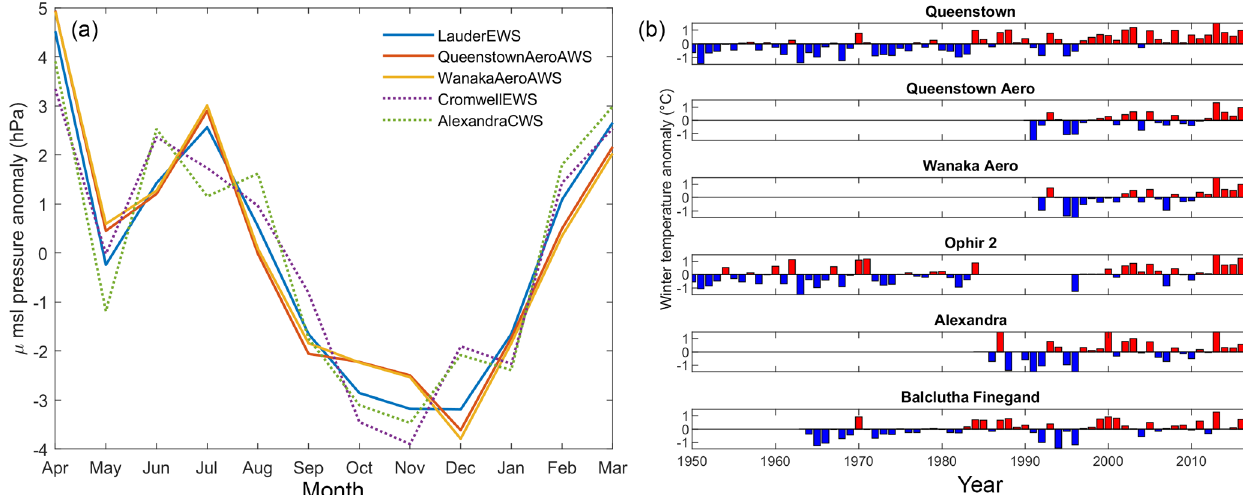
Figure 17. (a) Mean monthly atmospheric pressure (mean sea level) plotted for five climate stations within the Clutha Catchment. Record lengths vary from 8 (dashed lines) to 16 years (solid lines). (b) Anomalies in winter mean air temperature for low elevation stations in the Clutha Catchment. Anomalies for each station were calculated with respect to the mean of the station record. Data from the NIWA National Climate Database (CliFlo) (NIWA,